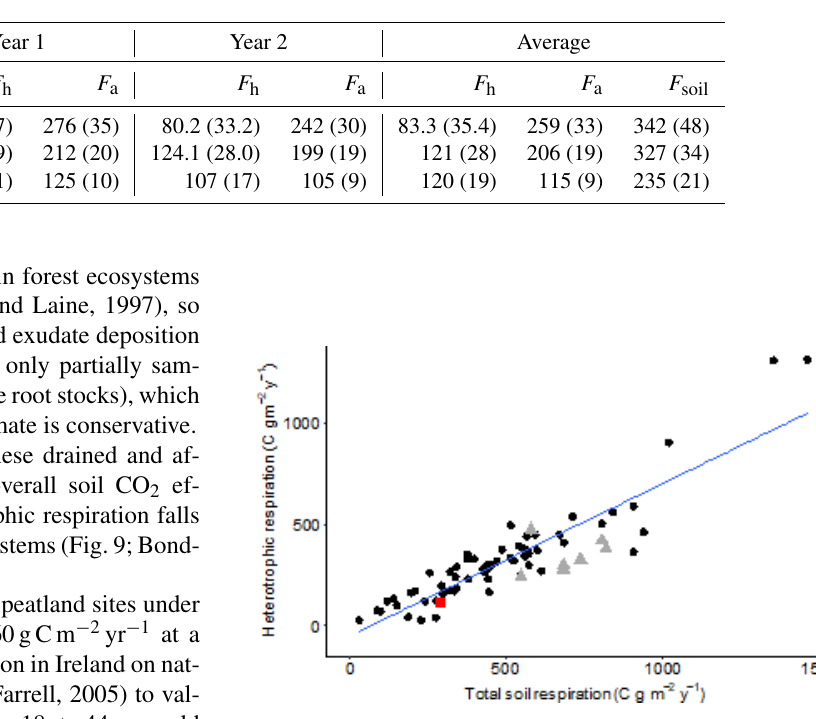
Table 5. Corrected for dead root decay in trenched plots, heterotrophic soil CO 2 efflux (excluding litter) ( F h ) and autotrophic ( F a ) fluxes (standard error in brackets) in gCm − 2 yr − 1 for both the first year (August 2014–August 2015) and second year (August 2015–August 2016) of the study.